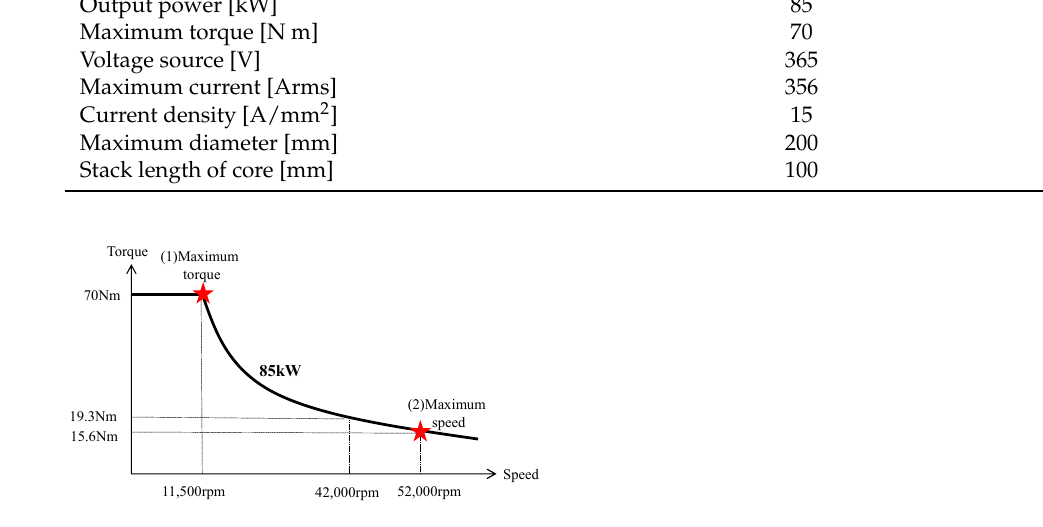
Figure 1. Target speed–torque characteristic.